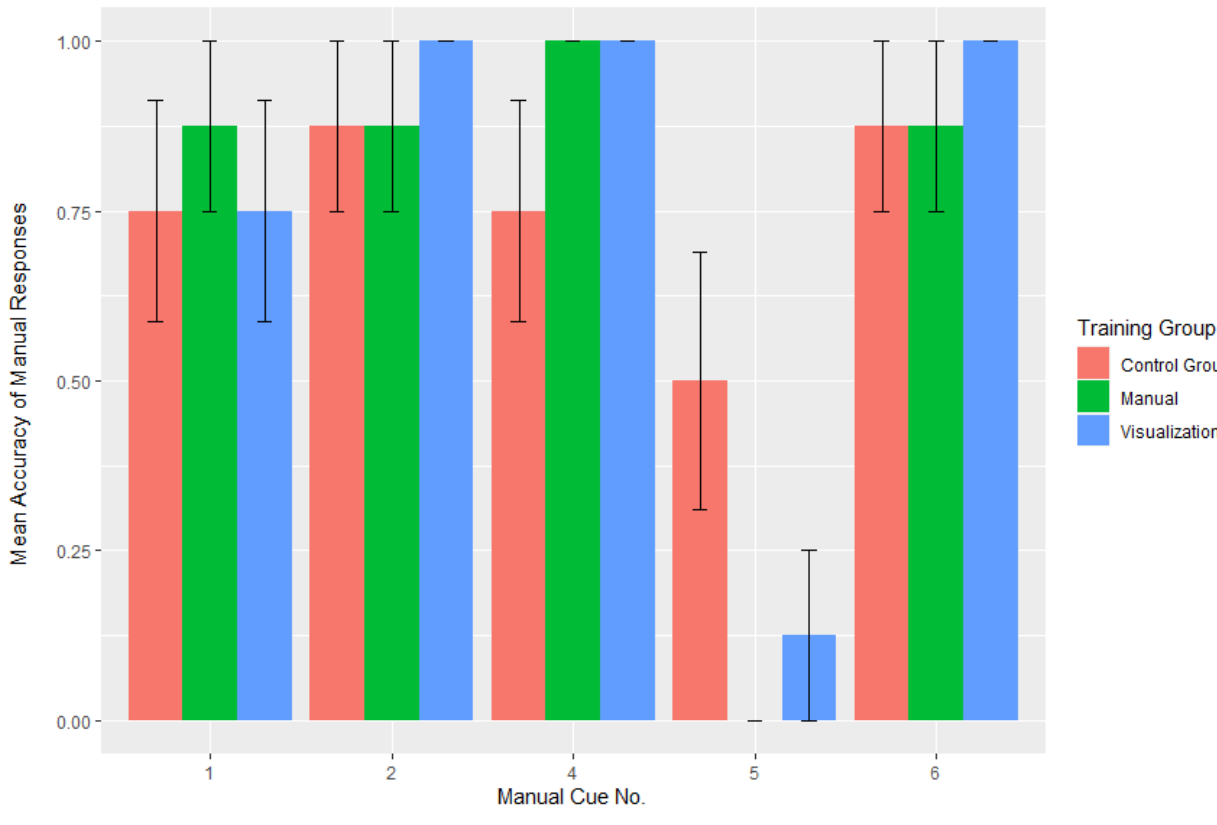
Figure 5 Drivers’ manual response